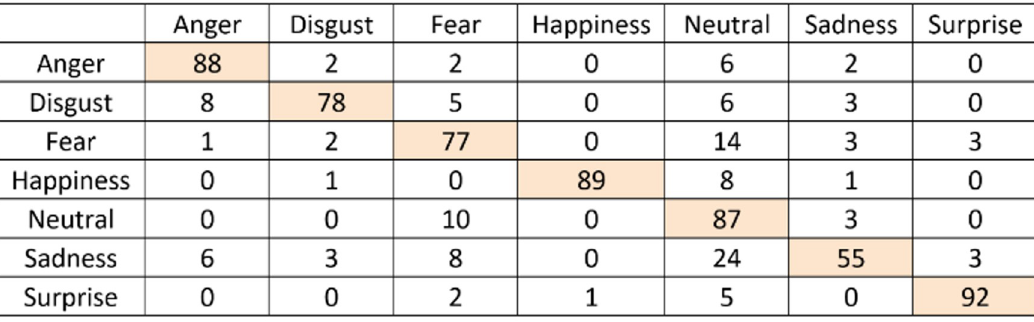
Fig 15. Confusion matrix for emotion recognition without the scoring